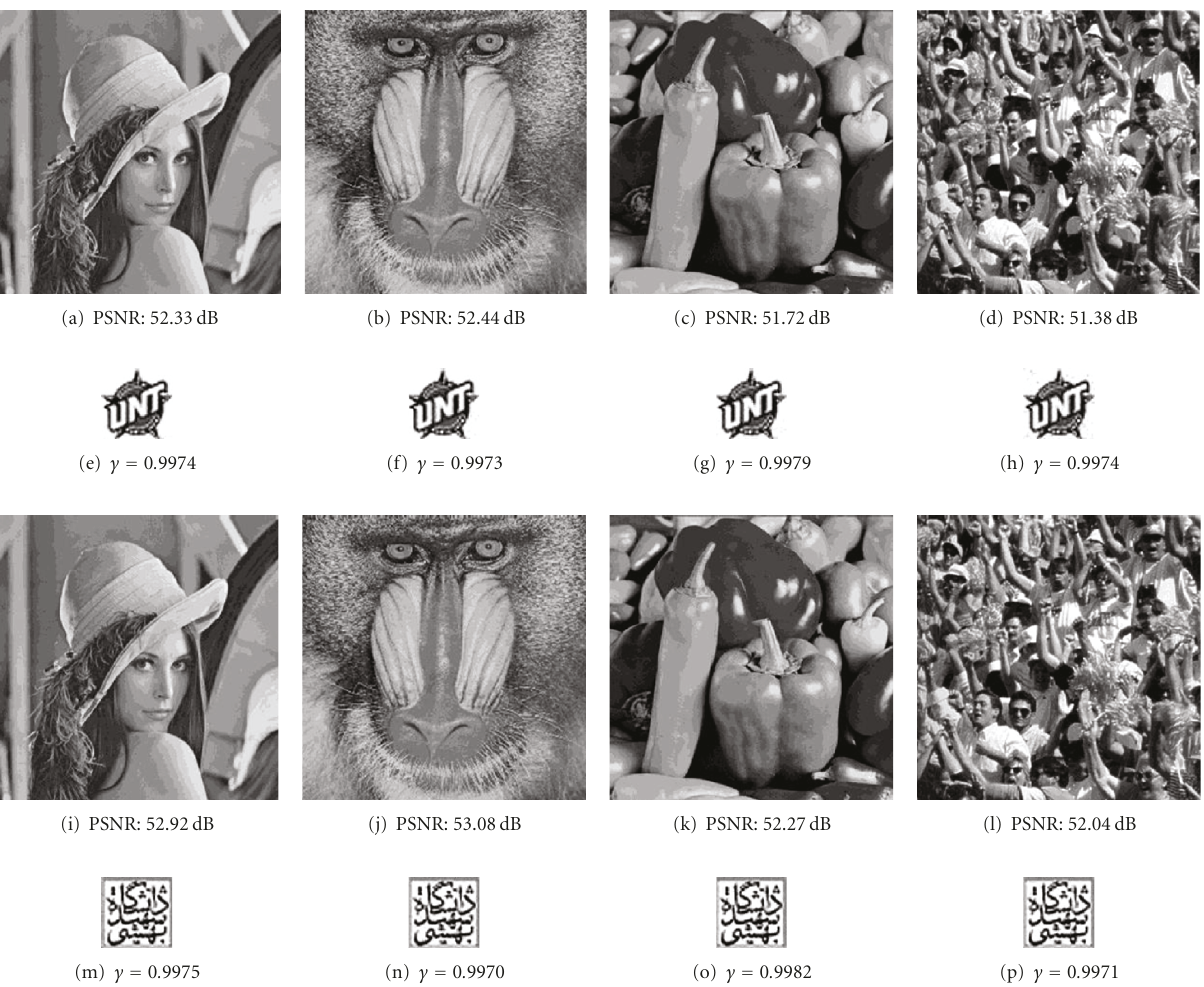
Figure 12: (a)–(d) Watermarked images after embedding 128 × 128 watermark image as shown in Figure 11(b). (e)–(h) Extracted watermarks from (a)–(d), respectively. (i)–(l) Watermarked images after embedding 128 × 128 watermark image as shown in Figure 11(d). (m)–(p) Extracted watermarks from (i)–(l),